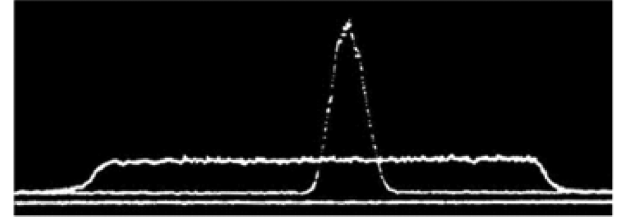
FIG. 19. Fast momentum cooling in